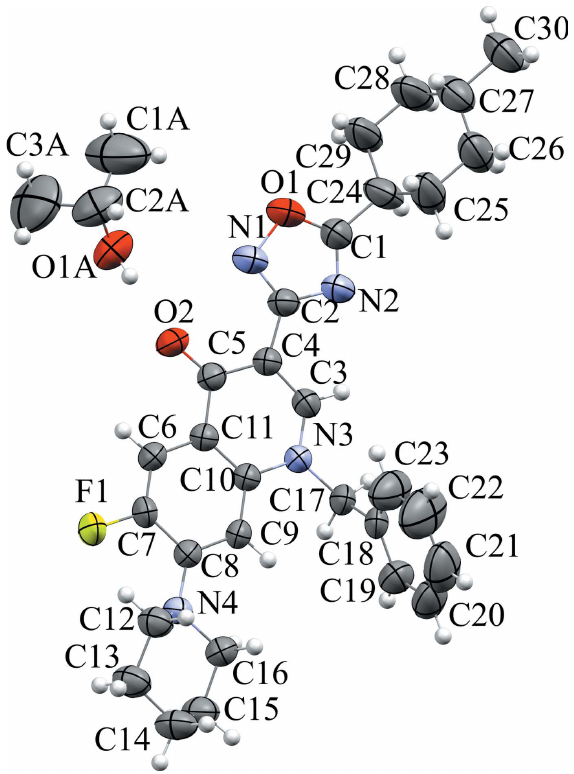
Figure 1 Molecular structure of the title compound. Displacement ellipsoids are shown at the 50% probability